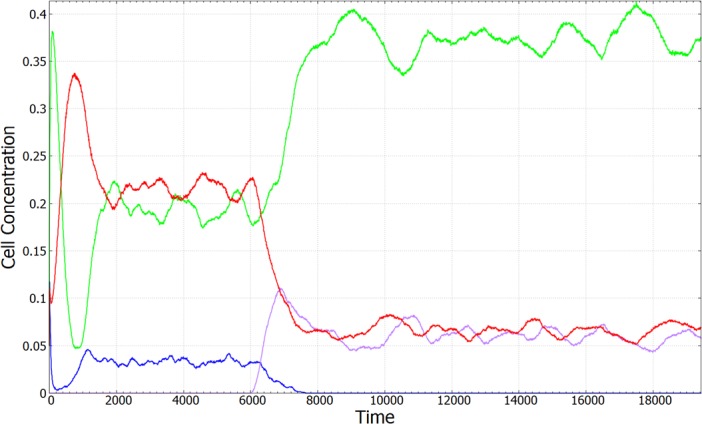
Time evolution of cell concentrations in a case where a low-rate producer replaces a non-producer.There are three cell-types initially: P with a = 110 (red), N (blue), and S (green). At t = 6000, a low-rate producer with a = 50 (violet) is introduced. The low-rate producer replaces the non-producer and a new stable coexistence is established. Parameters: b = 10, c = 0.001, δt = 0.01, u = 10−4, lattice size: L = 1024x1024.